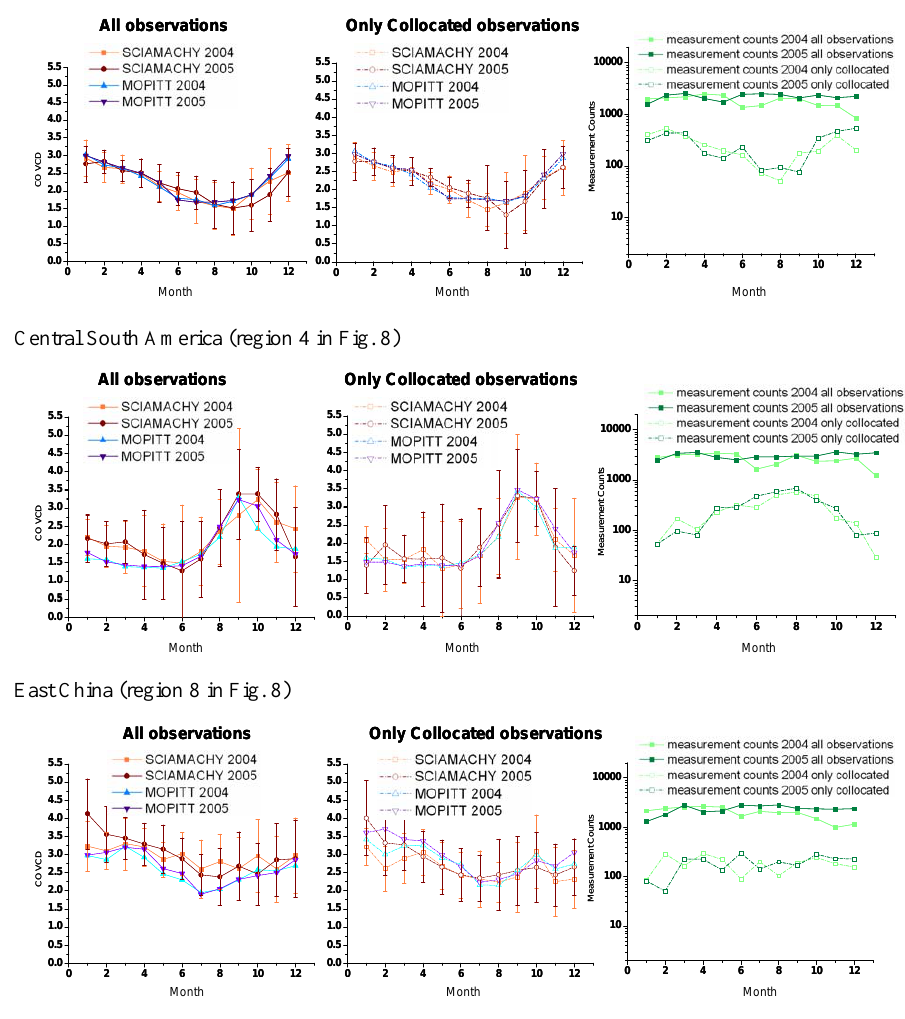
Fig. 11 Comparison of the monthly mean CO VCD (in units of 10 18 molec/cm 2 ) derived from SCIAMACHY and MOPITT. In the left column of the figure all observations of SCIAMACHY and MOPITT within the selected regions (see Fig. 8) are considered. In the middle column only collocated and coincident observations of SCIAMACHY and MOPITT are used. Similar comparisons for other regions indicated in Fig. 8 are presented in the appendix. The error bar of SCIAMACHY refers to the unbiased estimator of a weighted population variance. The numbers of observations are indicated in the right column (please notice the logarithmic scale).